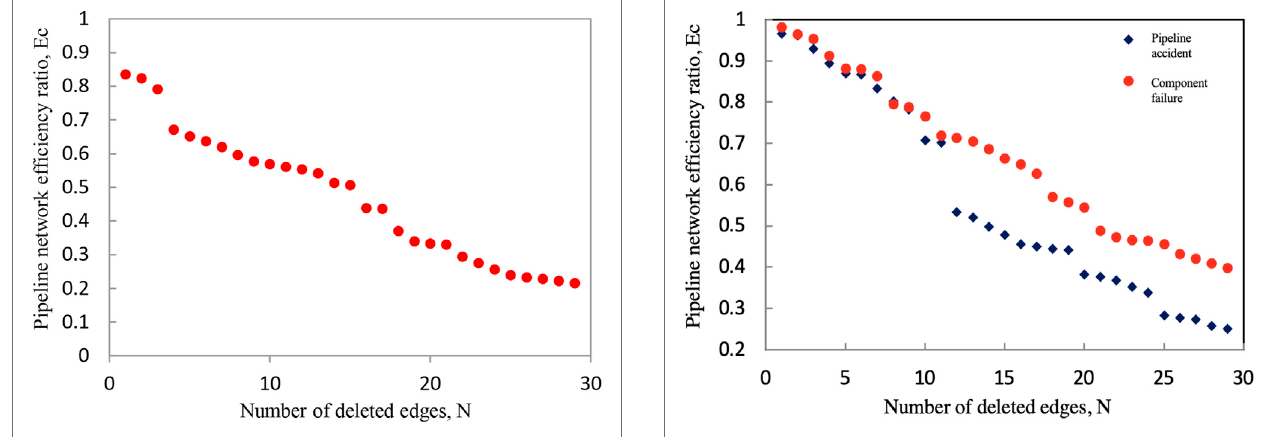
FIGURE 14 | The diagram of pipeline network ef fi ciency ratio.